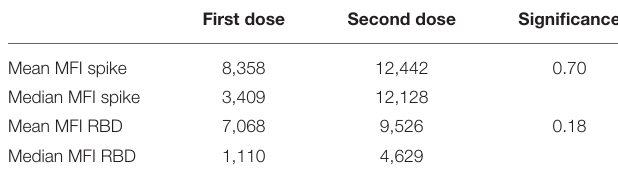
TABLE 2 | MFI by vaccine dose (both vaccines). TABLE 3 | Factors influencing seroconversion rates after 2 vaccine doses.